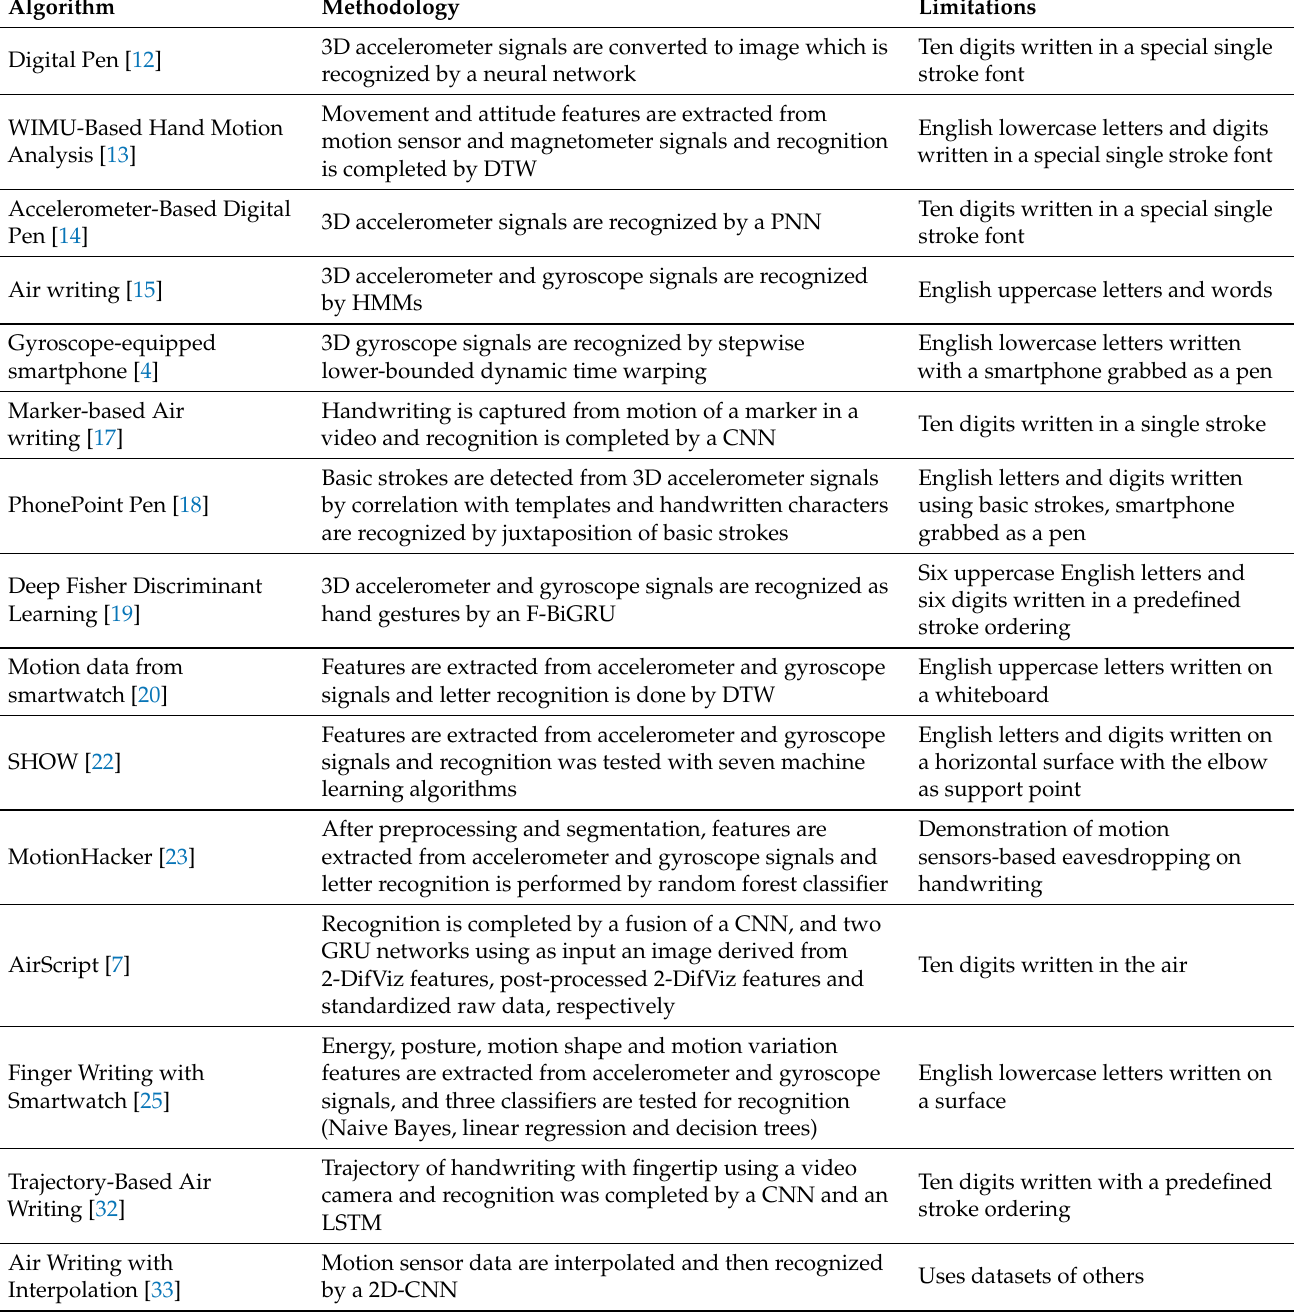
Table 1. Summary of related